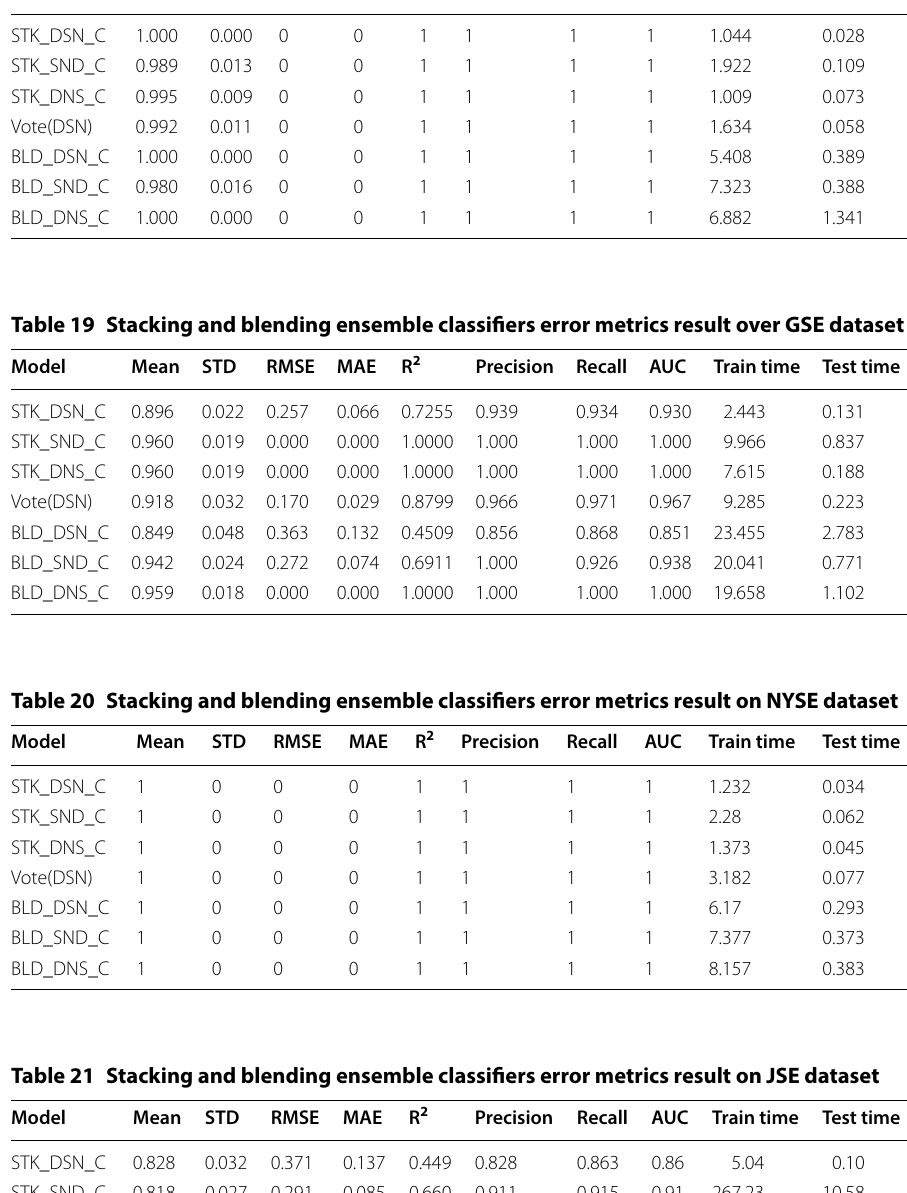
Table 18 Stacking and blending ensemble classifiers error metrics result over BSE dataset Model